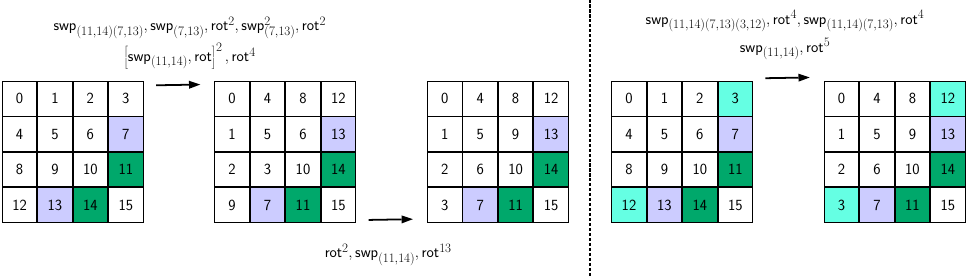
Figure 6: Transposition τ can also be done in 128 (resp. 64) cycles with 2 (resp. 3) swap